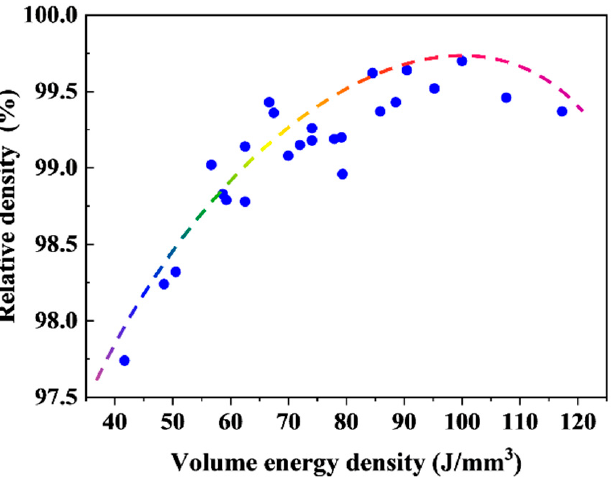
Figure 8. Relationship between relative density and volume energy density for LPBF-fabricated TA15 titanium alloy.